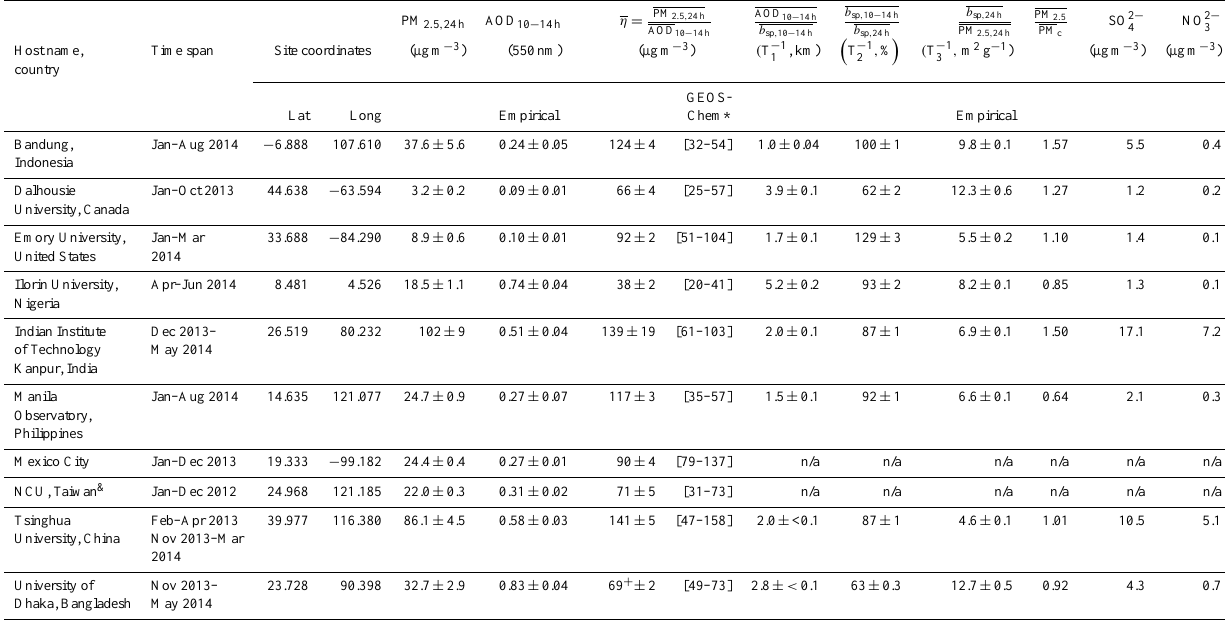
Table 2. Spatial variation in η and related